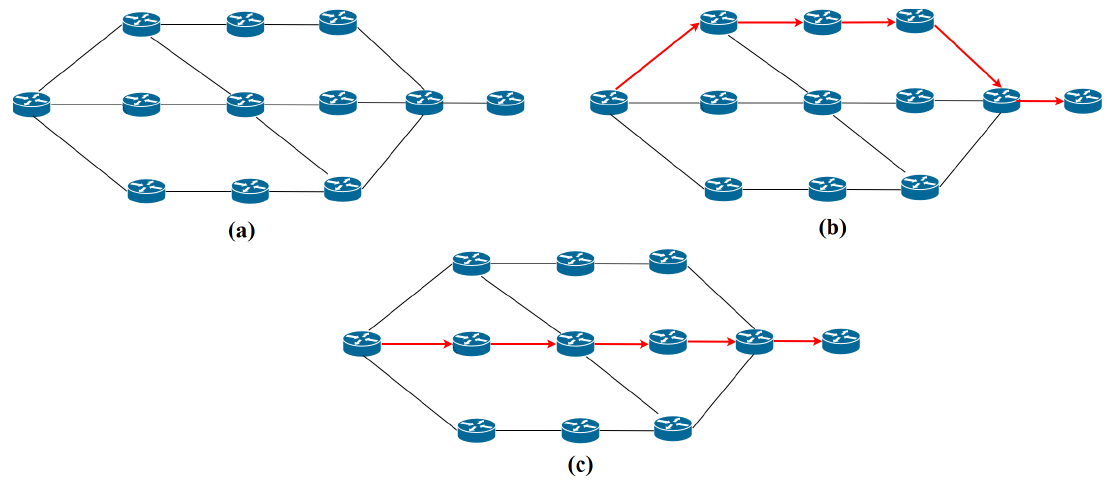
Figure 5. ( a ) Original Topology. ( b ) Shortest Path. ( c ) Shortest path determined using Algorithm 2 in our example